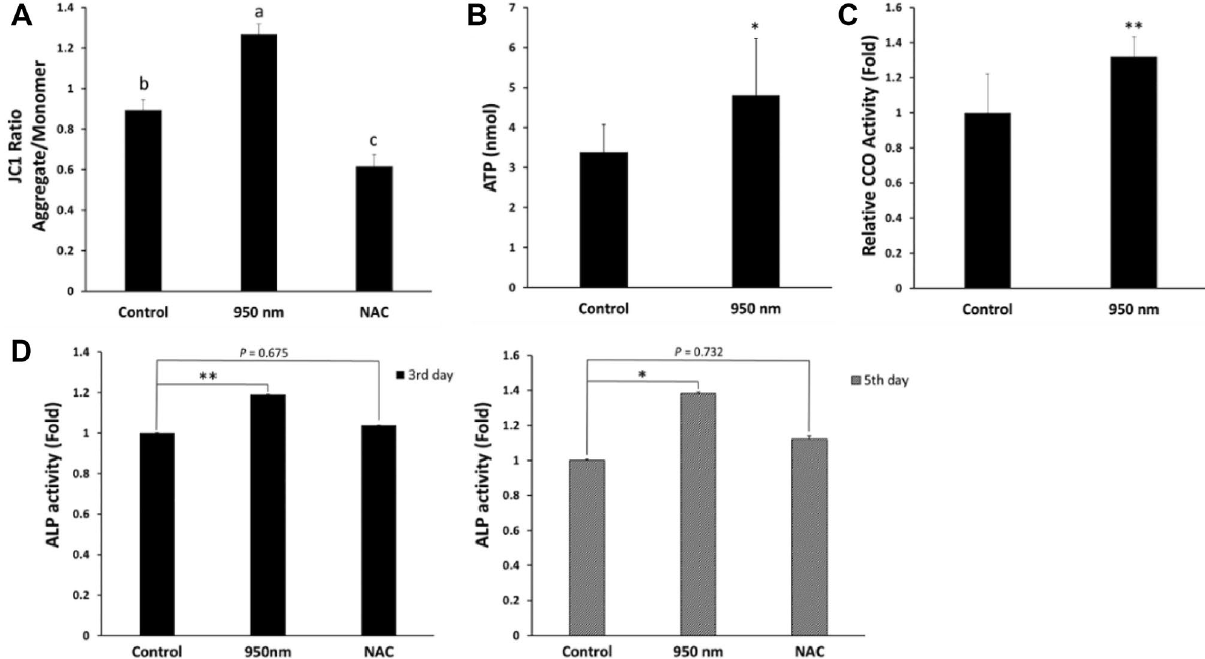
Figure 6. Mitochondrial activity and additive effect. ( A ) Mitochondrial membrane potential measured by JC1. The ratio of aggregate and monomer of JC1 is called the JC1 ratio proportional MMP. Data are mean ± SD (n > 5). According to Duncan’s test, different letters at tops of the columns indicate significant differences at P < 0.05. (B ) Comparing the amount of ATP with the control. ATP in each group was purified from 10 6 cells using the ATP assay kit. Data are mean ± SD (n = 10). * P < 0.05 compared to controls. ( C ) Oxygen consumption of cytochrome c oxidase. Activity of CCO for each group was measured by the CCO assay kit. Activated CCO indicates activated ETC. Data are mean ± SD (n > 5). * P < 0.05 compared to controls. ( D ) Relative ALP activity on and days 3 and 5. Data of each group are expressed as a multiple of those of the control group for the corresponding date. To verify that NIR irradiation has an additive effect of osteogenic differentiation in stem cells, ALP assays were performed on and days 3 and 5 after osteogenic induction. Data are mean ± SD (n = 10). * P < 0.05 compared to controls. P values were determined by one-way ANOVA ( A–D